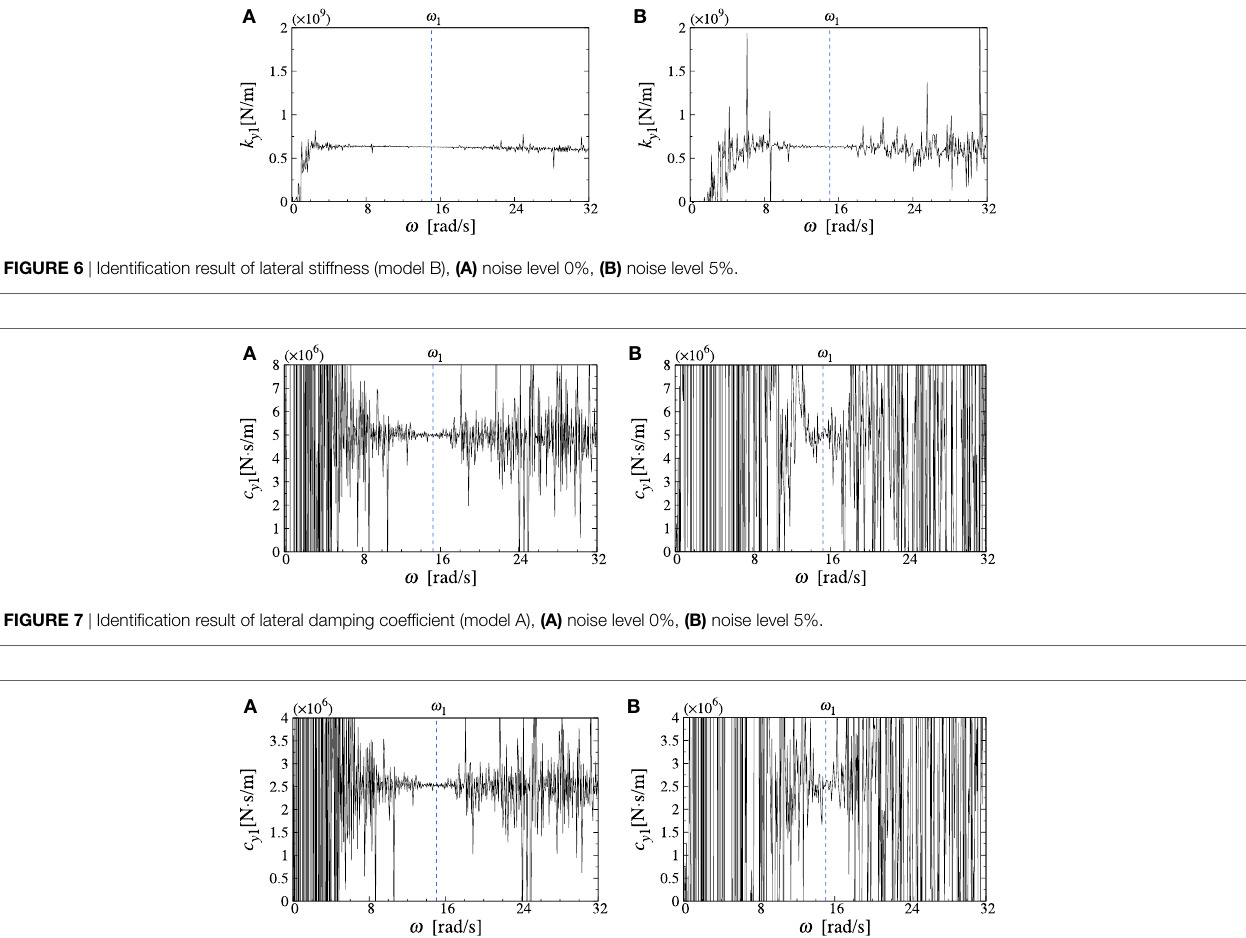
FIGURE 8 | Identification result of lateral damping coefficient (model B), (A) noise level 0%, (B) noise level 5%.